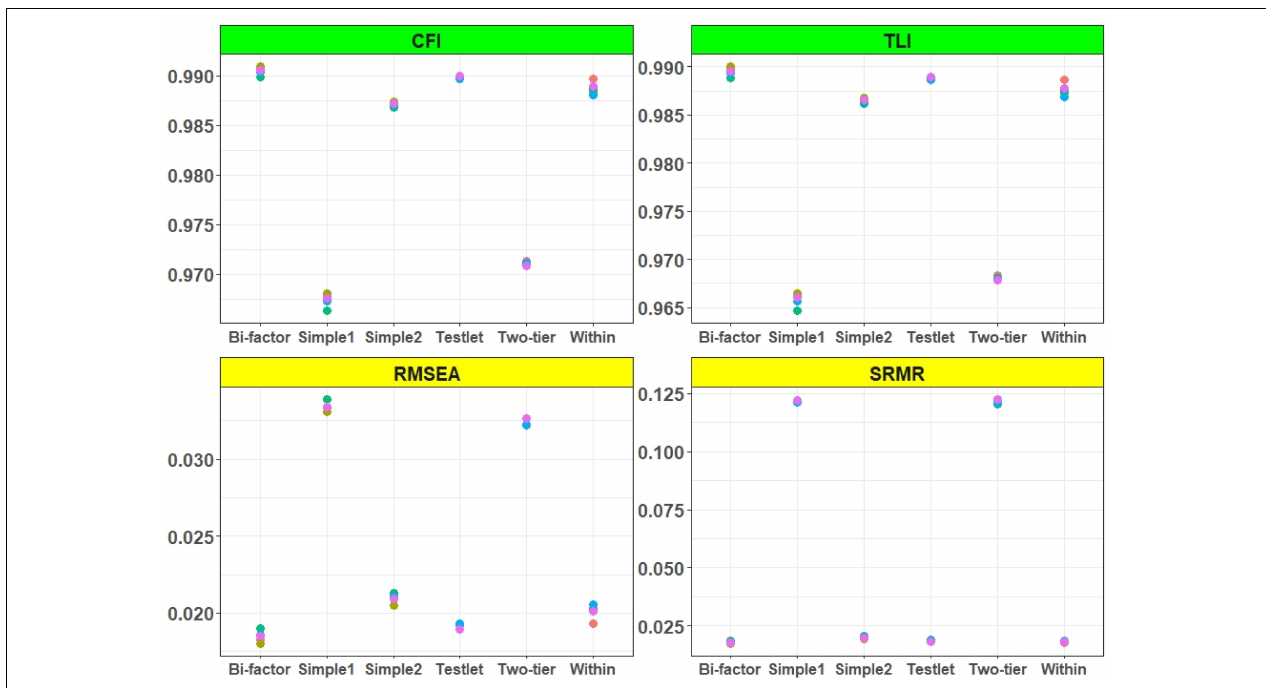
FIGURE 4 | M2* statistics for multidimensional models. Simple 1 and Simple 2 show the uncorrelated and correlated simple structure. All models were estimated with the 2PL